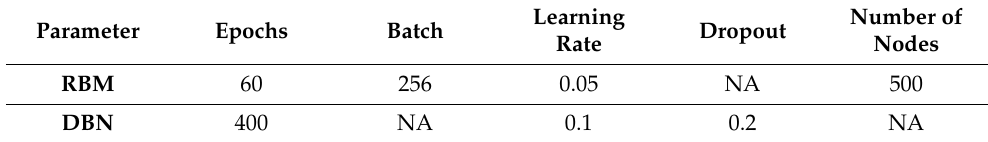
Table 1. Hyperparameters